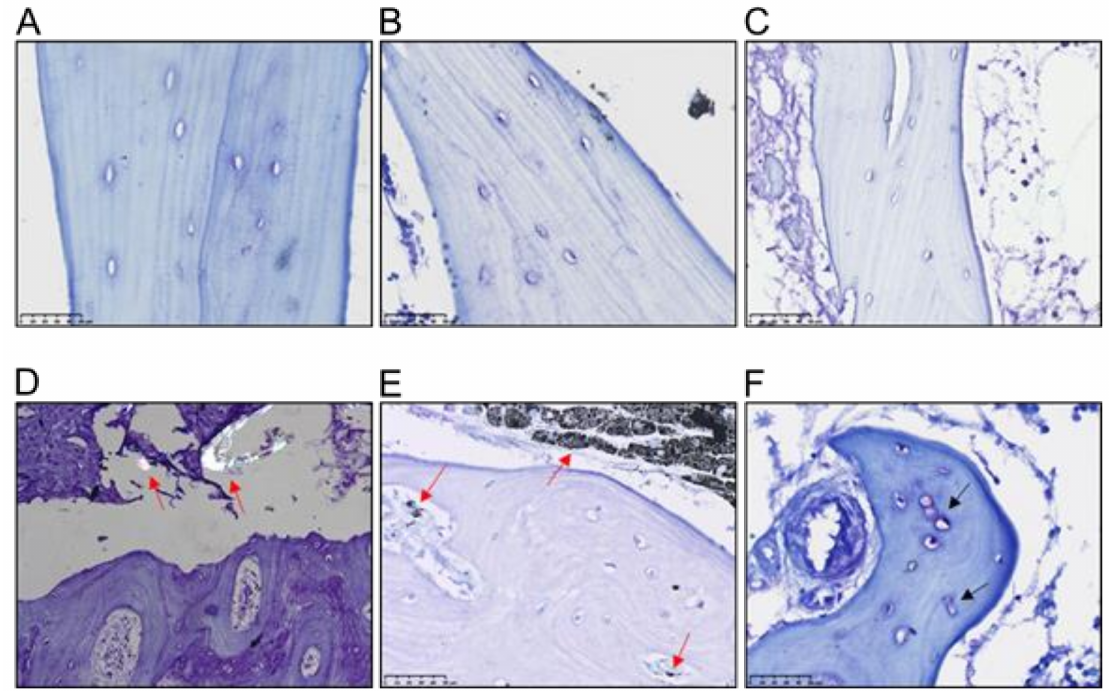
Figure 2. Bone biopsies were obtained from Primary THR ( A – C ) and Revision THR surgeries ( D – F ) and stained with toluidine blue. Images depict sections from three individual patients per group. Revision THR biopsies shown enlarged osteocyte lacunae with the presence of PE particles (2D), as well as metal particles and granuloma in 2E (red arrows). Evidence of osteocyte coalescence is discernible in 2F (black